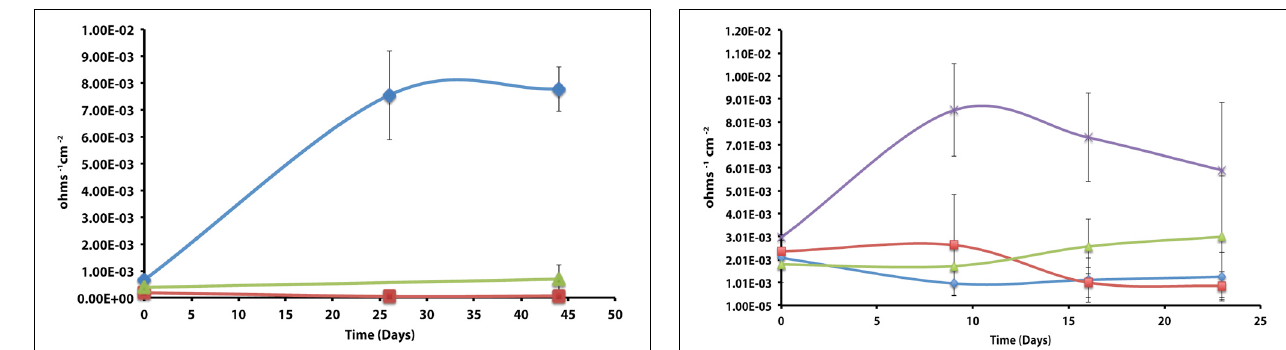
FIGURE 3 | Instantaneous corrosion rates (1/ Rp ) for pure cultures of S. aciditrophicus strain SB ( ) and syntrophic co-cultures with M. hungatei strain JF-1 ( ) and Desulfovibrio sp . strain G11 ( ) as well as an uninoculated basal medium controls amended with 20mM of crotonate ( ) (standard deviation incubations n = 3, medium controls n =